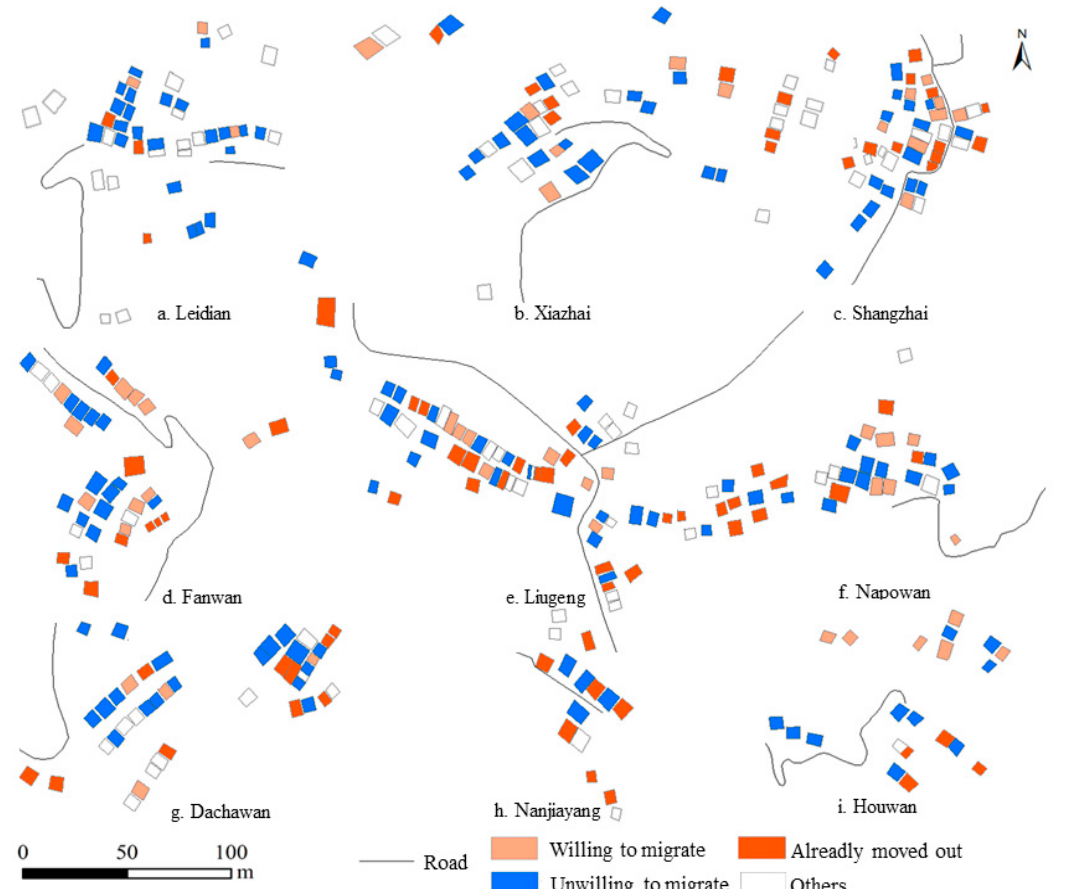
Figure 4. Distribution of households with different attitudes towards migration to urban areas in the nine communities of Sihe village.